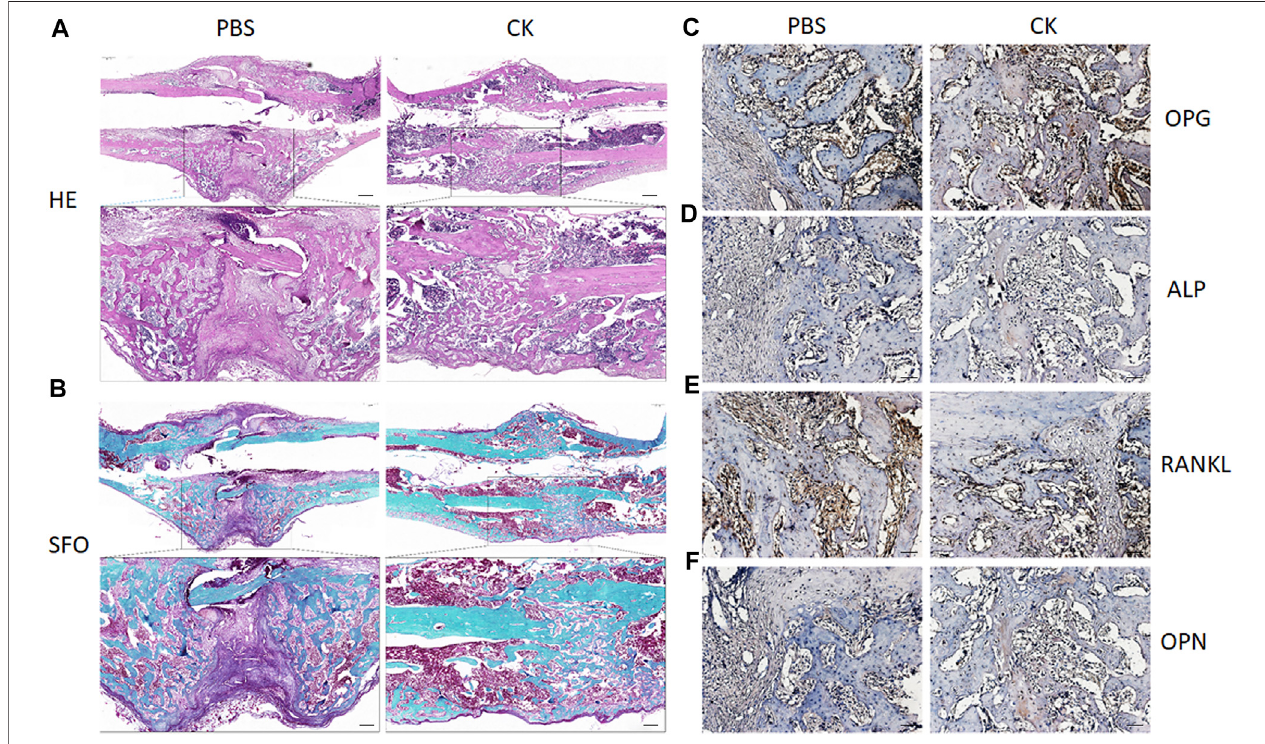
FIGURE4| H&E,SafraninO-FastGreen,andimmunohistochemicalexaminationoffracturecallus. (A) RepresentativeimagesofH&Estainingoffracturecallusesin PBSandCKgroups.Insetsindicatetheregionsshownintheenlargedimages(lower).Scalebar:500 μ m. (B) RepresentativeimagesofSafraninO-FastGreenstainingof fracturecallusesinPBSandCKgroups.Insetsindicatetheregionsshownintheenlargedimages(lower). (C – F) Representativeimagesofimmunohistochemicalanalysis of OPG, ALP, RANKL and OPN of fracture calluses in PBS and CK groups. Scale bar = 50 μ m.